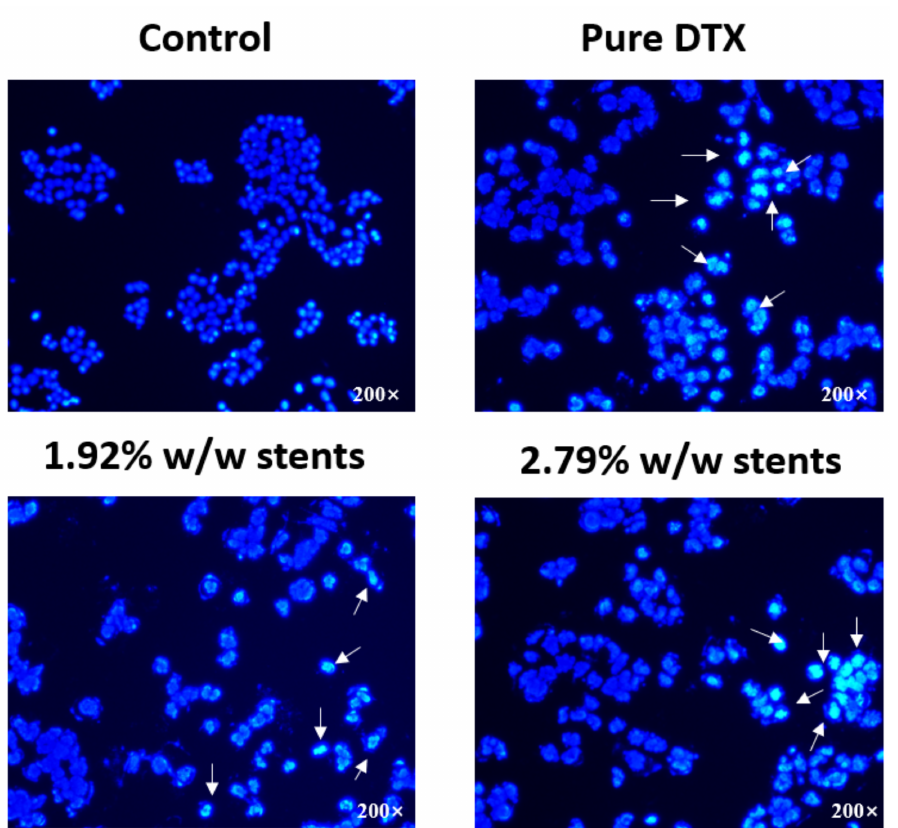
Figure 5. Fluorescence microscopy images showing the morphological differences of the nuclei of human oesophageal cancer cells (KYSE30) after incubation with DTX released from the stents and pure DTX (1 µ g/mL for all) for 48 h. Cells were fixed and stained with DNA-binding fluorochrome Hoechst 33,342 before visualisation. Arrows indicate characteristic apoptotic cells. ( n =